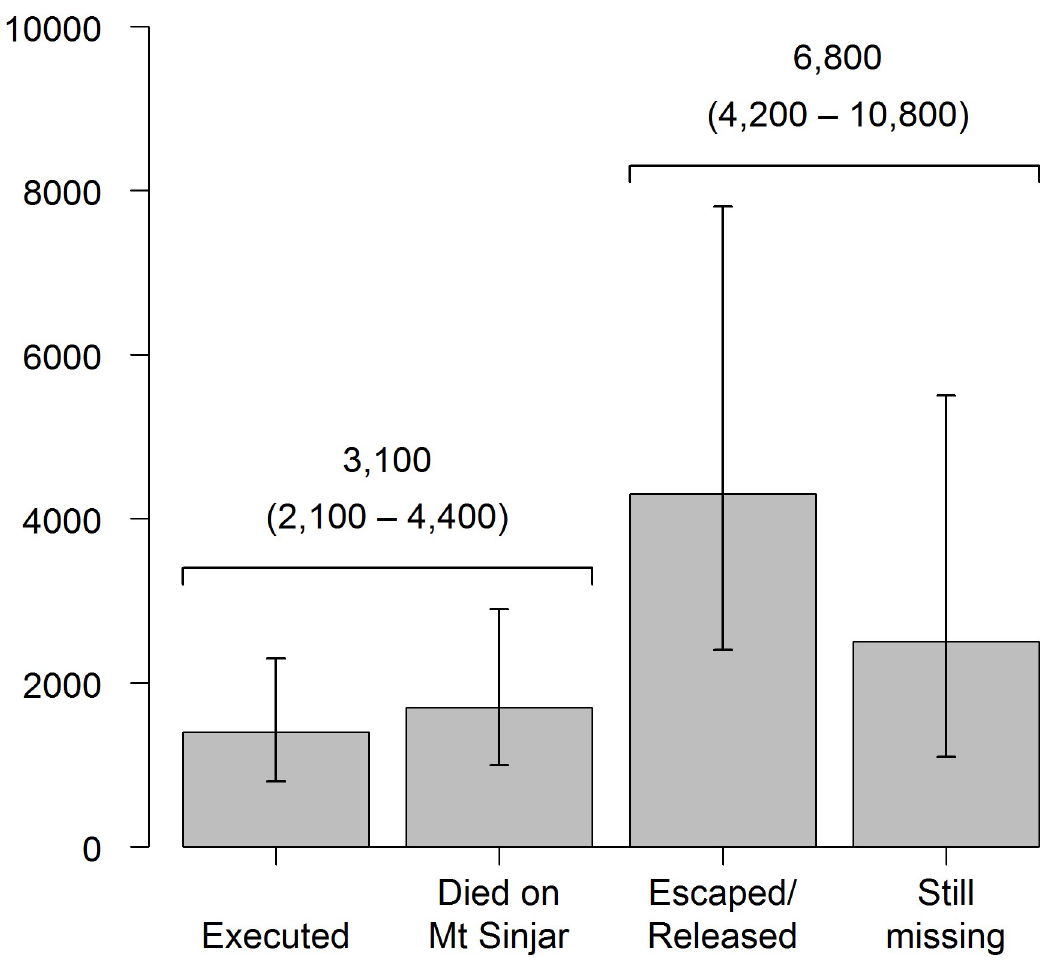
Fig 2. Estimated toll of killings and kidnappings with 95% CIs.